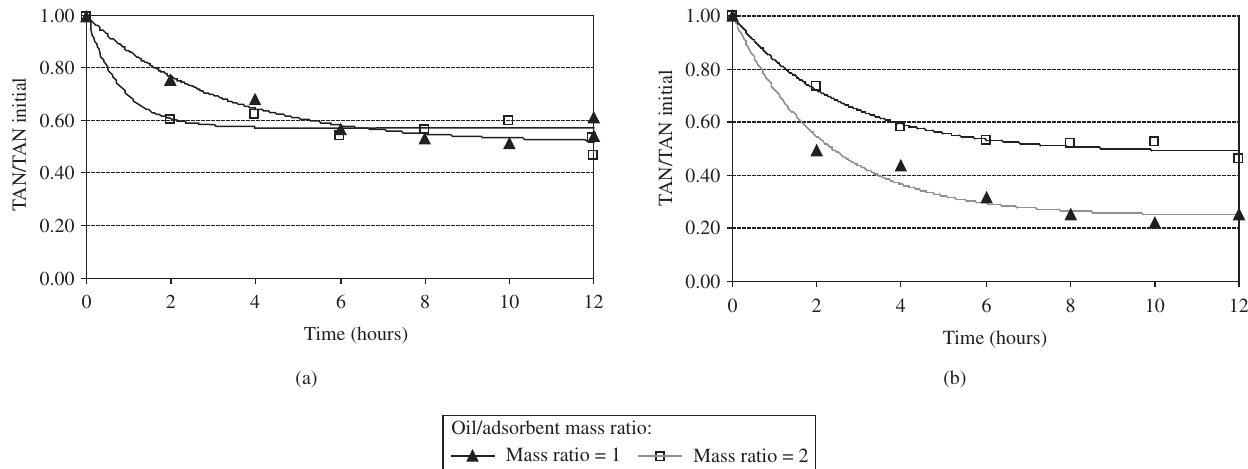
Figure 4. Adsorption kinetics curves varying oil/adsorbent mass ratio. a) TCO 626G clay; and b) Selexsorb CD